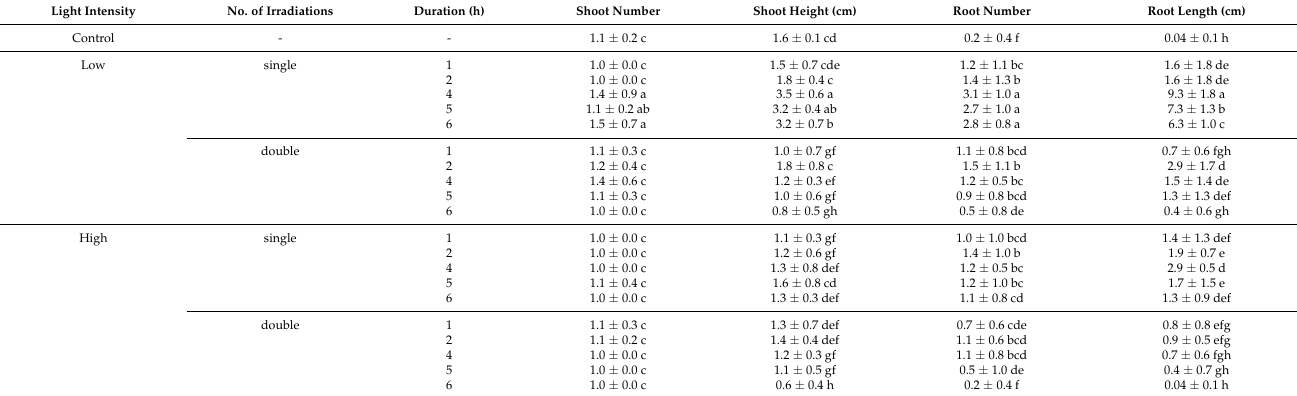
Values are means ± SD; means followed by the same letters within a column are not significantly different ( p < 0.05) according to Duncan’s multiple range test